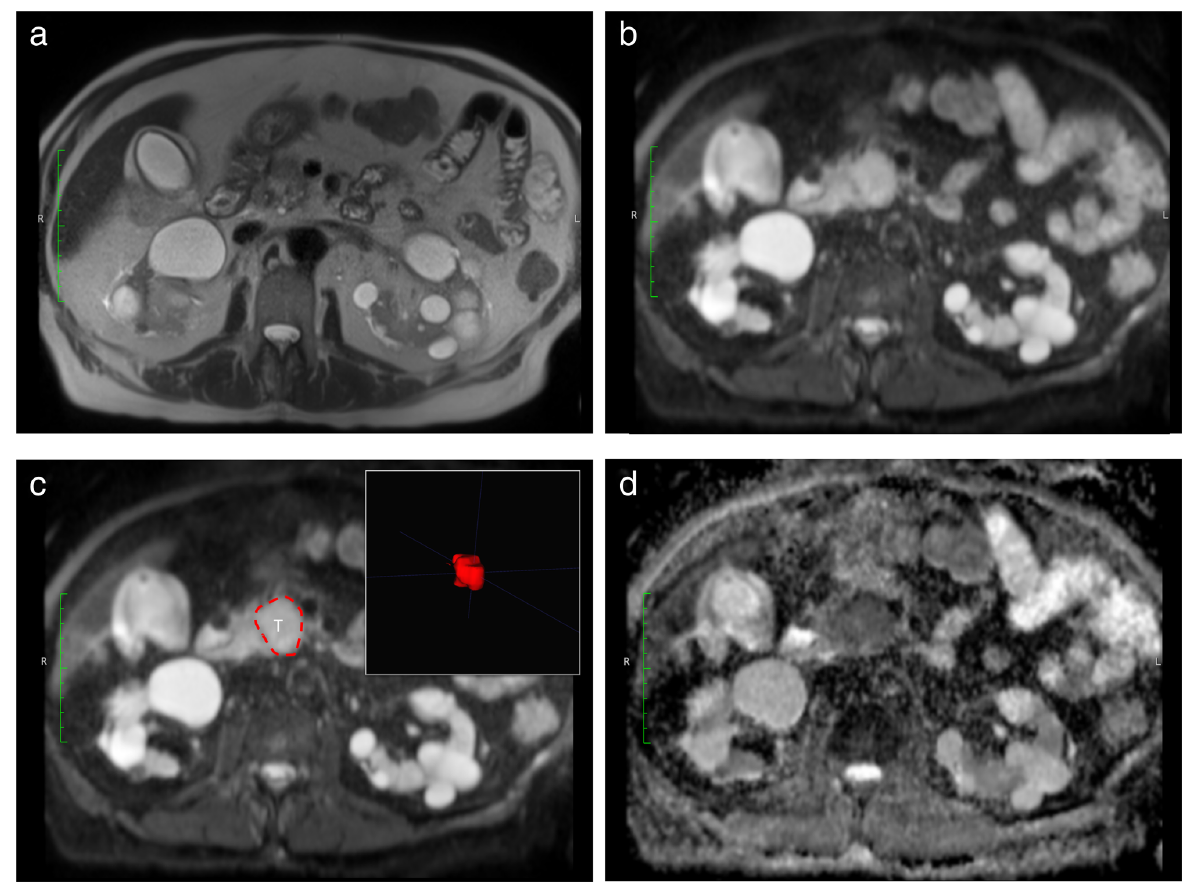
Fig. 1 Exemplary case showing a ductal adenocarcinoma of the pancreatic head on T2-weighted images ( a ), b = 600s/mm 2 ( b ), the segmentation image including a three-dimensional rendering (inset) and a region-of interest (T) of the tumor ( c ), and the apparent diffusion coefficient map ( d